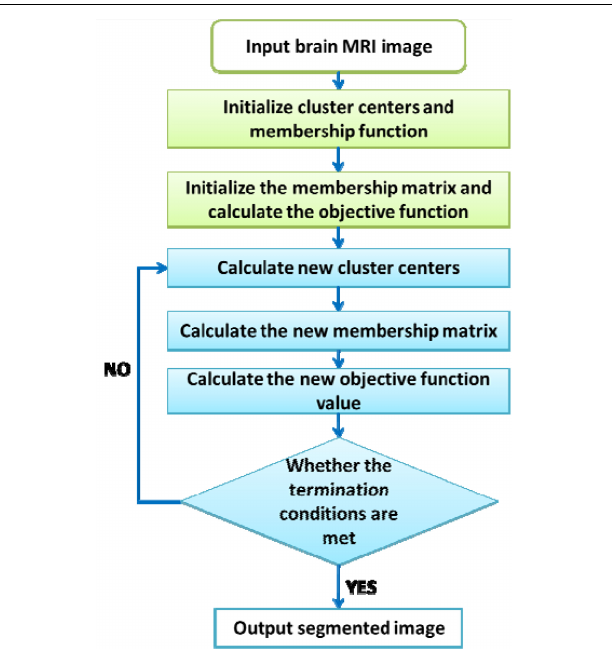
FIGURE 3 | B-MRI-IS process based on FCM.